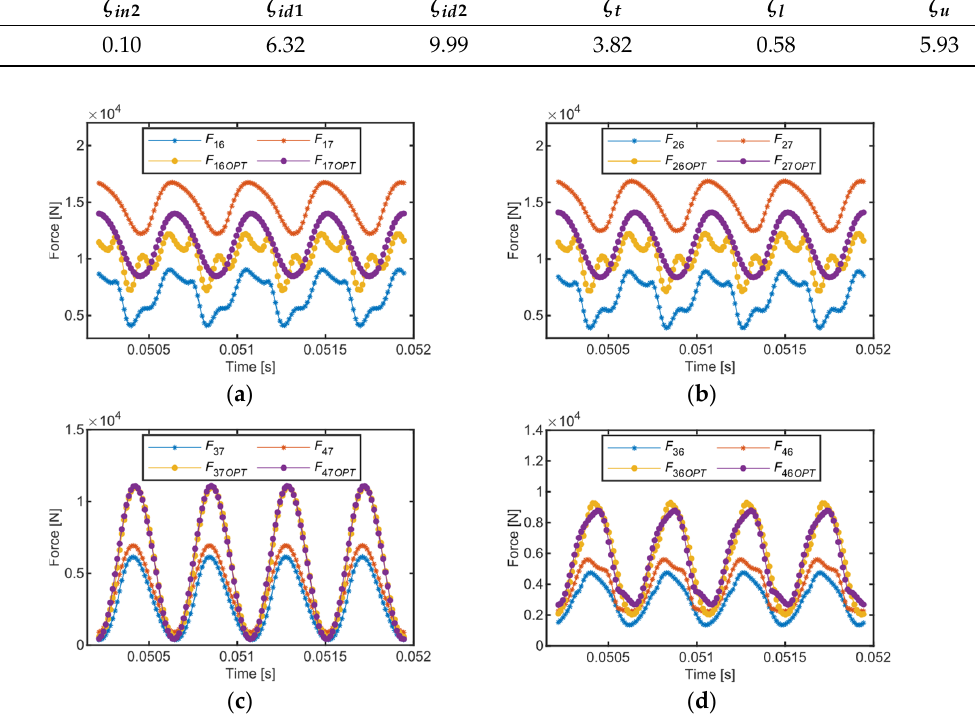
Figure 22. Dynamic meshing force curve before and after optimization: ( a ) Input Gear 1; ( b ) Input Gear 2; ( c ) idler gear–upper face gear; ( d ) idler gear–lower face gear.